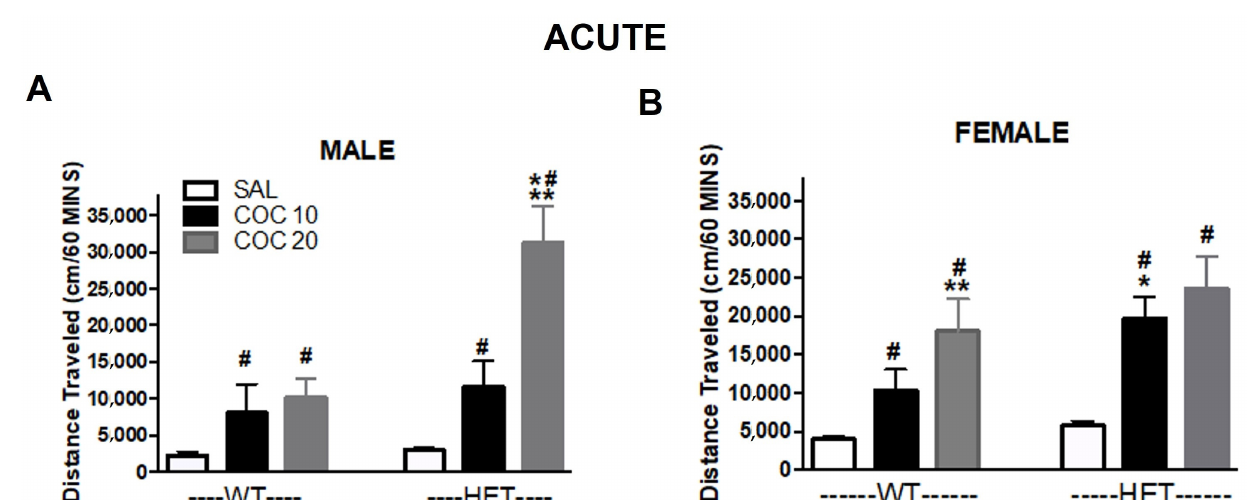
Figure 2. Effect of cocaine on cumulative distance traveled in DAT mutant rats. Cumulative time (30 min after acute treatment) is represented across conditions (SAL = saline, COC 10= 10 mg/kg cocaine; COC 20= 20 mg/kg cocaine) in males ( A ) and females ( B ). # p < 0.05 compared to SAL; * p < 0.05 compared to WT; ** p < 0.05 compared to 10 mg/kg. Mean ± SEM. (males: WT N = 15, HET N = 36; females: WT N = 24, HET N = 24).